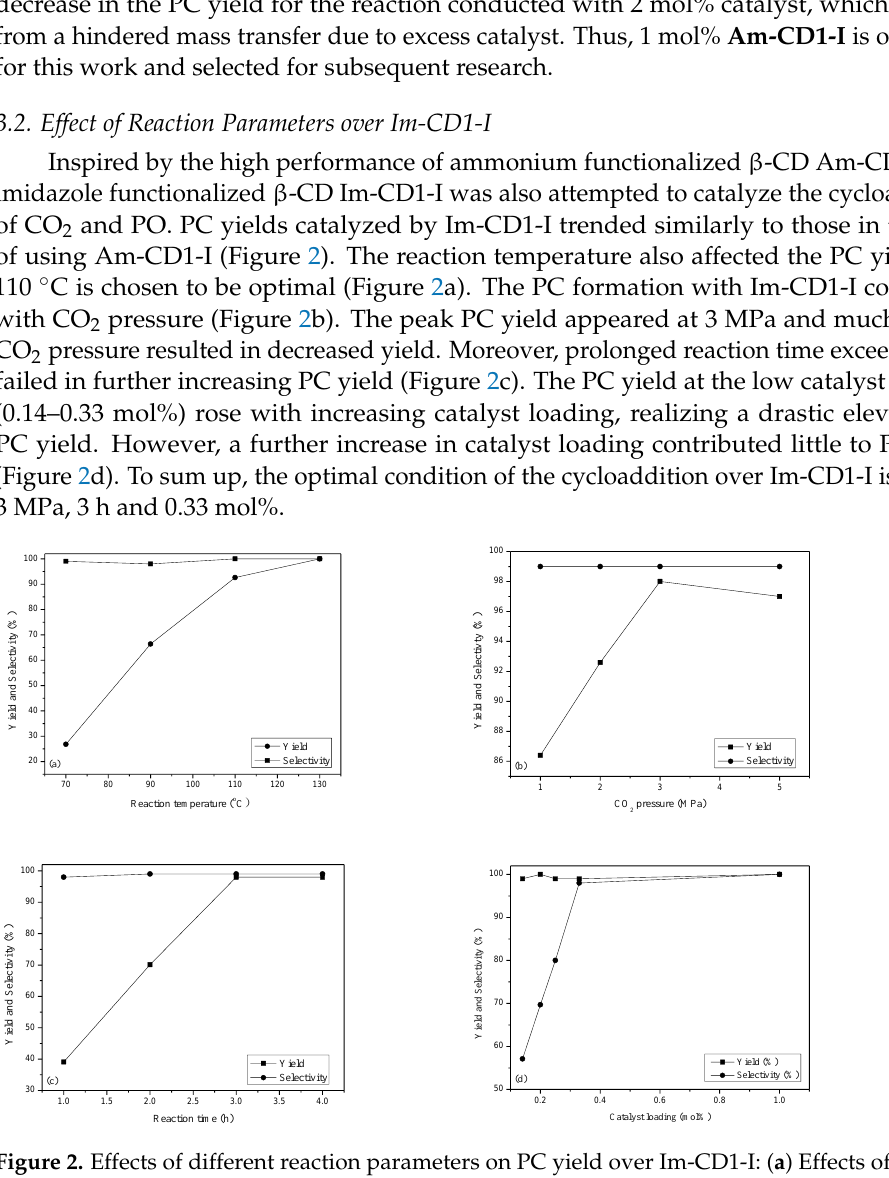
Figure 2. Effects of different reaction parameters on PC yield over Im-CD1-I: ( a ) Effects of reaction temperature, conditions: PO (5 mL, 71.5 mmol), Im-CD1-I (0.33 mol%), CO 2 pressure 2 MPa, time 3 h; ( b ) Effects of CO 2 pressure, conditions: PO (5 mL, 71.5 mmol), Im-CD1-I (0.33 mol%), reaction temperature 110 °C, time 3 h.; ( c ) Effects of reaction time, conditions: PO (5 mL, 71.5 mmol), Im-CD1-I (0.33 mol%), reaction time 110 °C, CO 2 pressure 3 MPa; ( d ) Effects of catalyst loading, conditions: PO (5 mL, 71.5 mmol),reaction time 110 °C, CO 2 pressure 3 MPa, reaction time 3 h. Comparison of the optimal conditions for Am-CD1-I and Im-CD1-I (130 °C, 1 MPa, 5 h,1 mol% Am-CD1-I vs. 110 °C, 3 MPa, 3 h, 0.33 mol% Im-CD1-I) found that ammonium